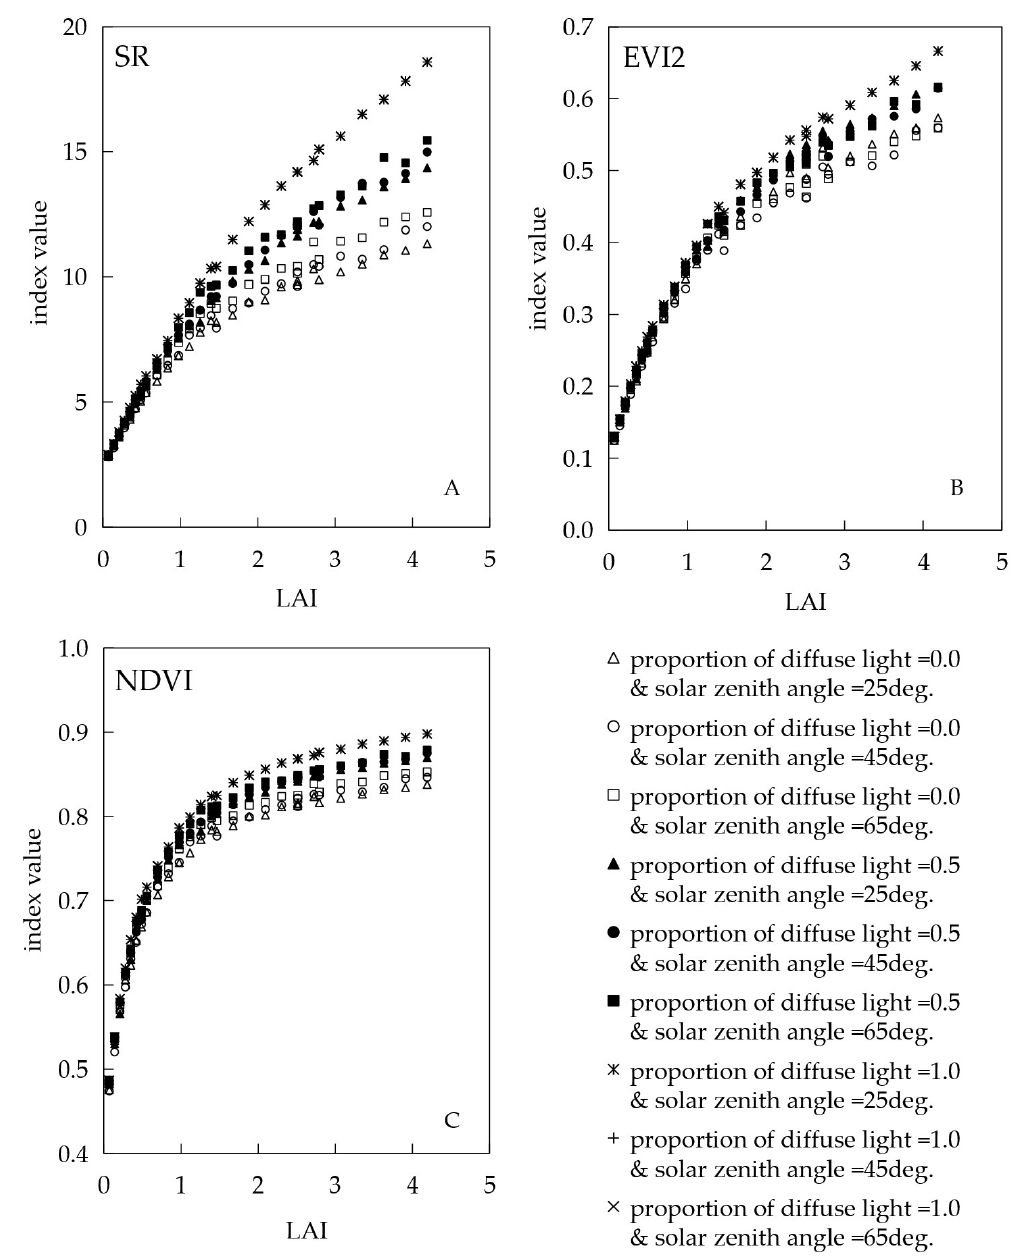
Figure 3. Vegetation indices calculated using the reflectance in Figure 2. The vegetation indices (Simple Ratio (SR, A), Enhanced Vegetation Index 2 (EVI2, B), and Normalized Di ff erence Vegetation Index (NDVI, C)) were calculated by Equations (1), (2) and (3), respectively. LAI was calculated by multiplying the number of plants, the plant foliage volume and LAD in the foliage. Symbols distinguish the proportion of di ff use light at 0.0, 0.5, and 1.0 and the solar zenith angle at 25, 45, and 65